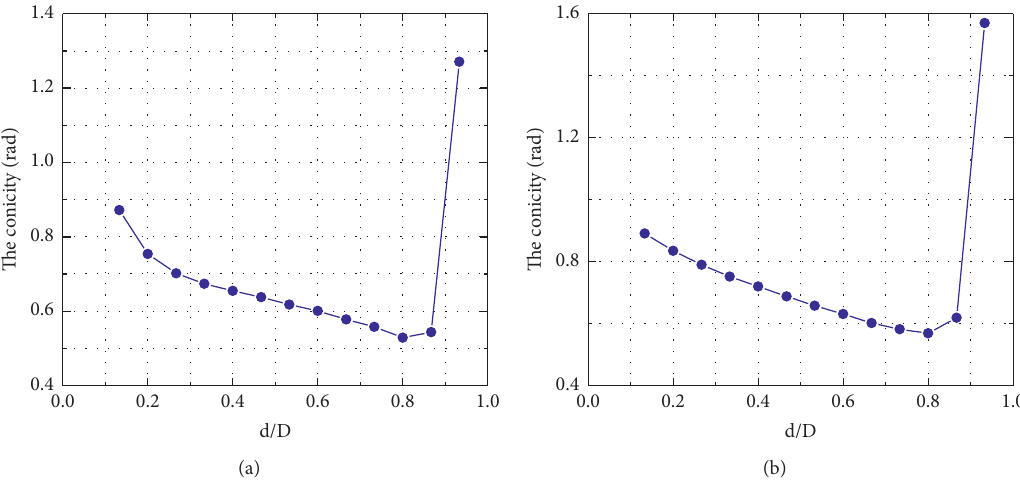
Figure 10: The conicities when b / D is constant. (a) b / D is 0.4 and (b) b / D is